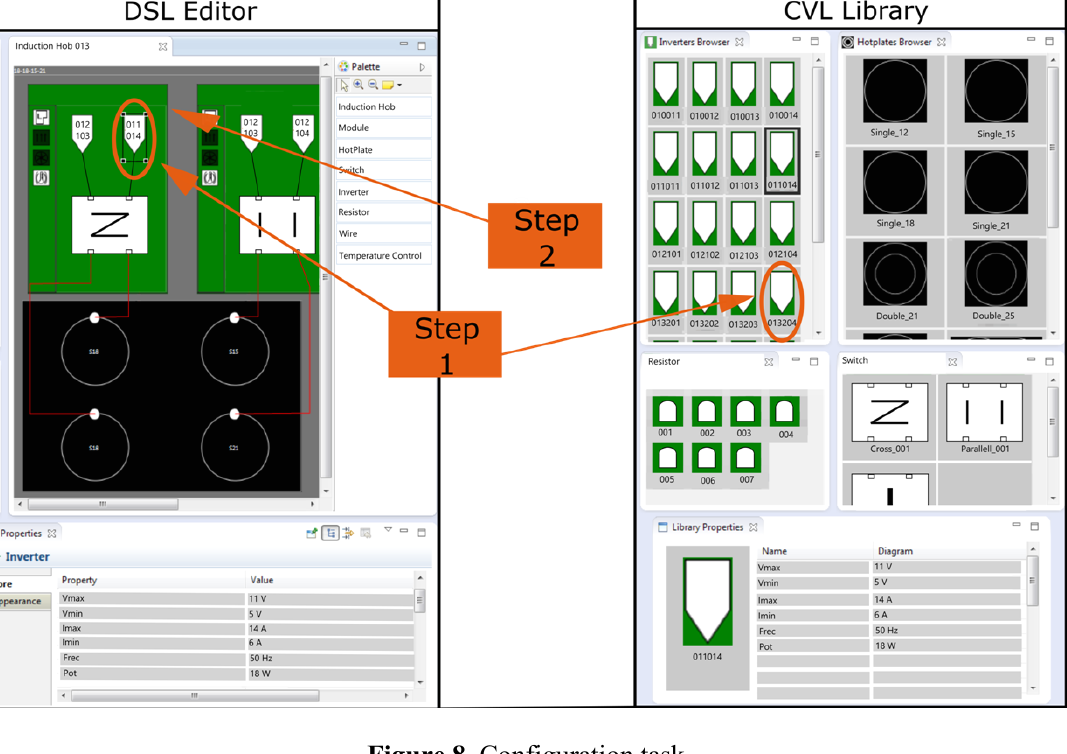
Figure 8. Configuration task